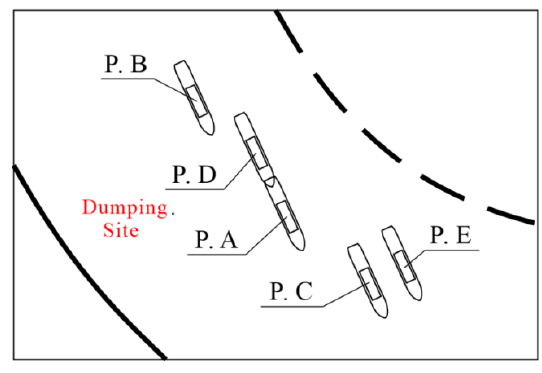
Figure 2. Arrangements of the dumping locations.